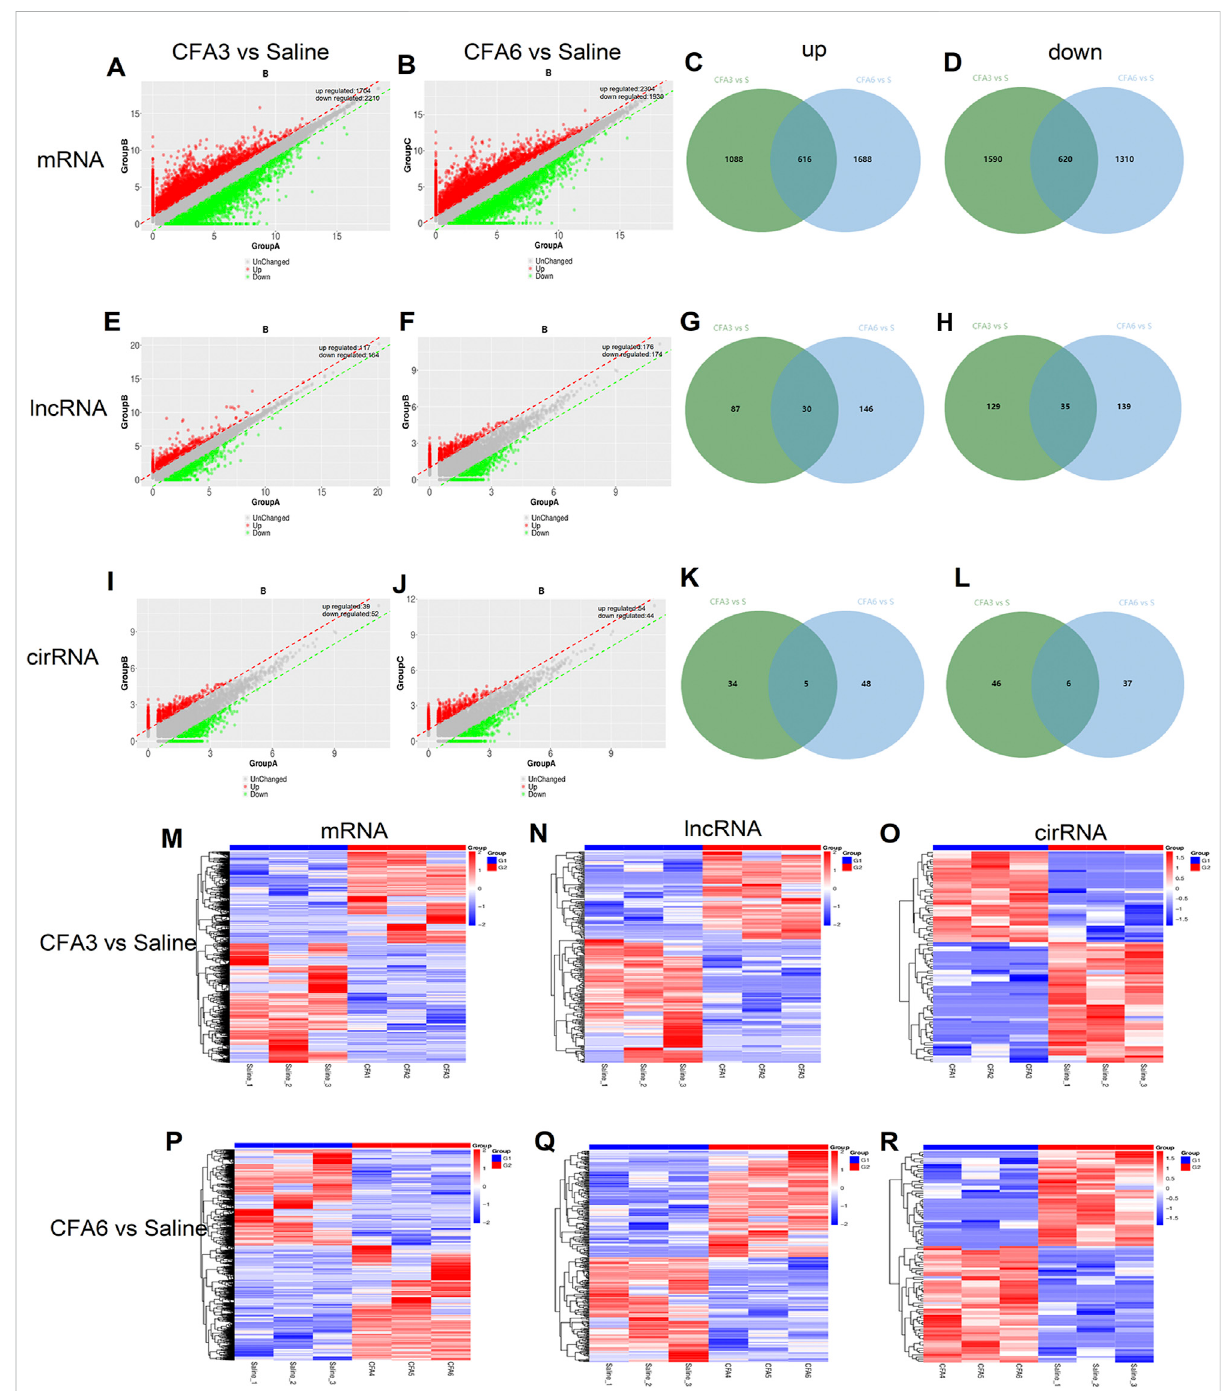
FIGURE 3 TherobustchangesingeneexpressionofmRNAs,longnoncodingRNAs(lncRNAs),andcircularRNAs(circRNAs)withinthetrigeminalganglion (TG)afterCFA-TMJ injection. (A,B) mRNAsweresigni fi cantly changedintheTGonCFA3DandCFA6D,respectively. (C,D) Venndiagramwasapplied to further determine whether these upregulated and downregulated DE mRNAs showed coexpression patterns across CFA3D and CFA6D. (E,F) lncRNAs were signi fi cantly changed in the TG on CFA3D and CFA6D, respectively. (G,H) Venn diagram was applied to further determine whether these upregulated and downregulated DE lncRNAs showed coexpression patterns across CFA3D and CFA6D. (I,J) circRNAs were signi fi cantly changed in the TG on CFA3D and CFA6D, respectively. (K,L) Venn diagram was applied to further determine whether these upregulated and downregulated DE circRNAs showed coexpression patterns across CFA3D and CFA6D. (M – R) the clustered heatmaps of DE mRNAs (M,P), DE LncRNAs (N,Q), and DE circRNAs (O,R) revealed distinct gene expression patterns after temporomandibular joint disorders (TMD) on CFA3D and